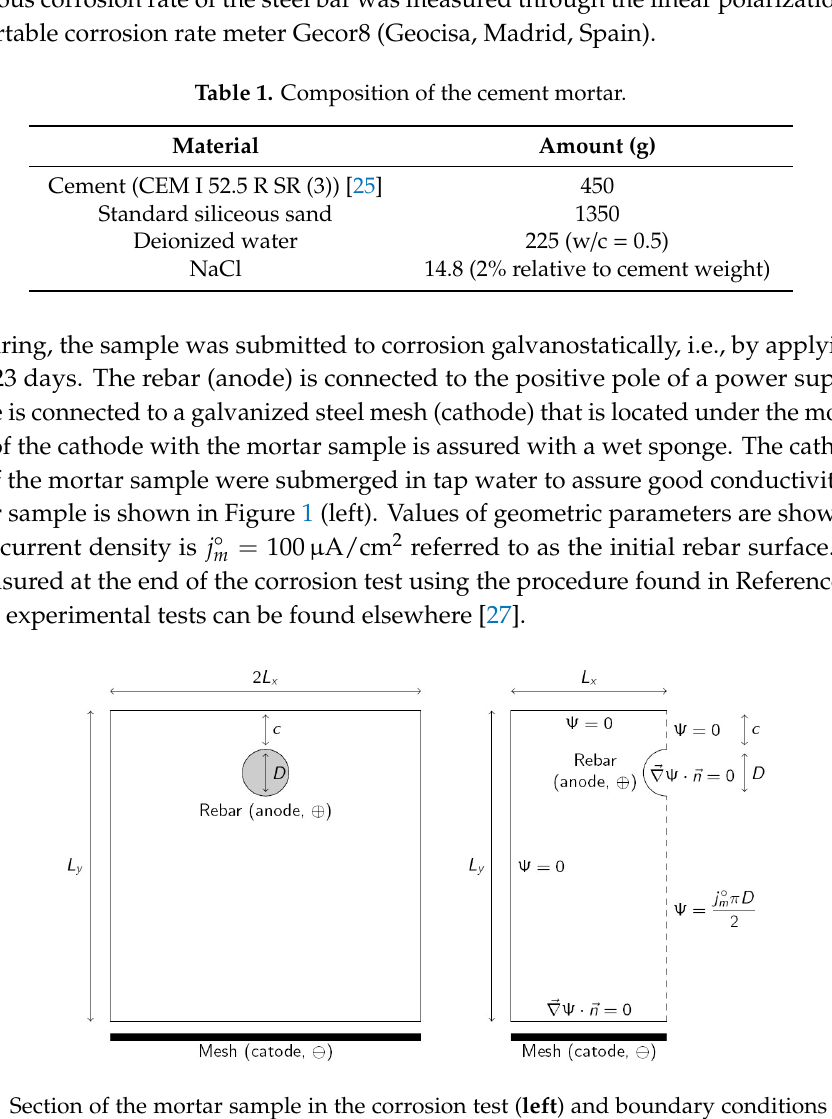
Figure 1. Section of the mortar sample in the corrosion test ( left ) and boundary conditions applied ( right , see text for